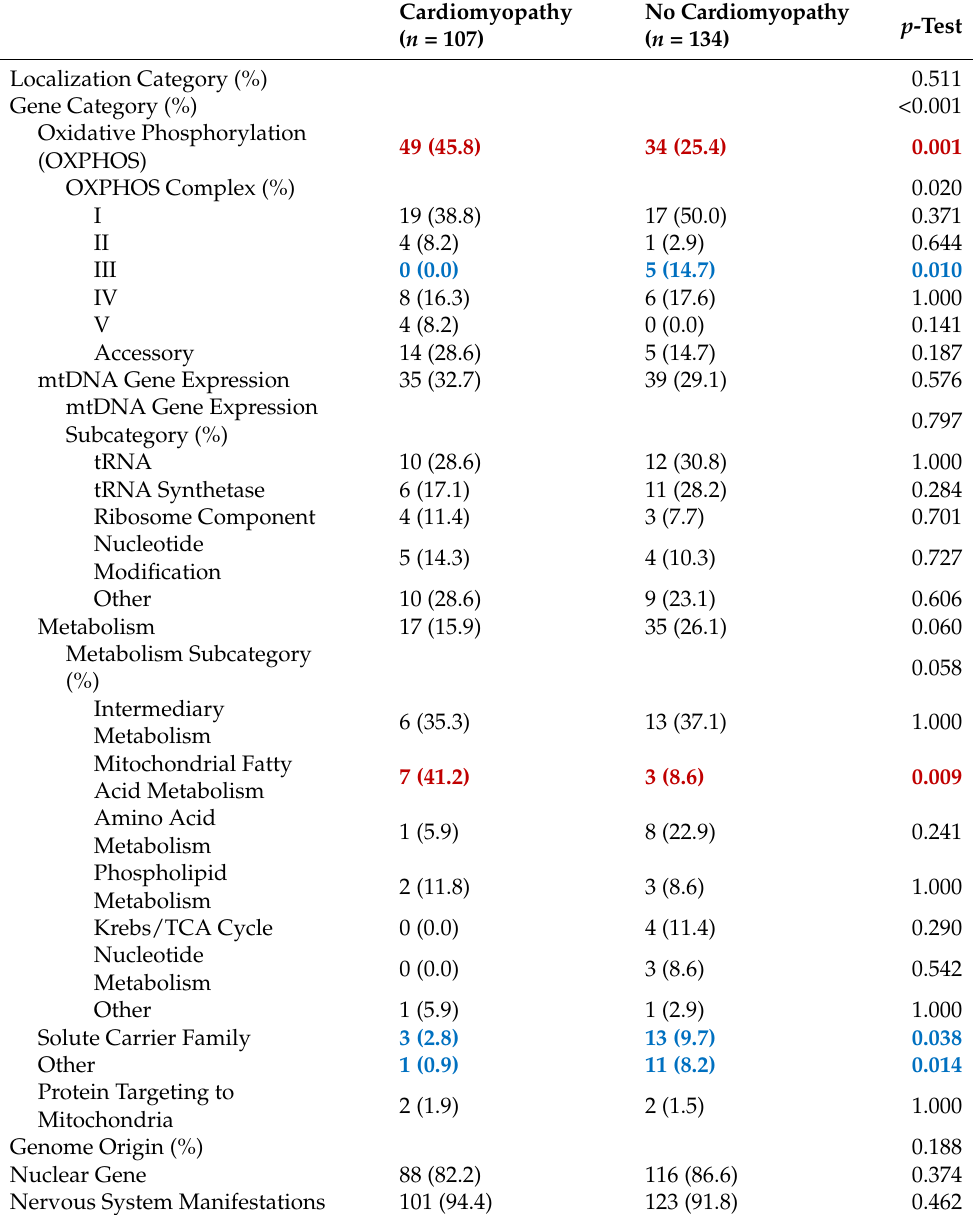
Table 1. Characteristics of Mitochondrial Disease-Causing Genes by the Presence or Absence of